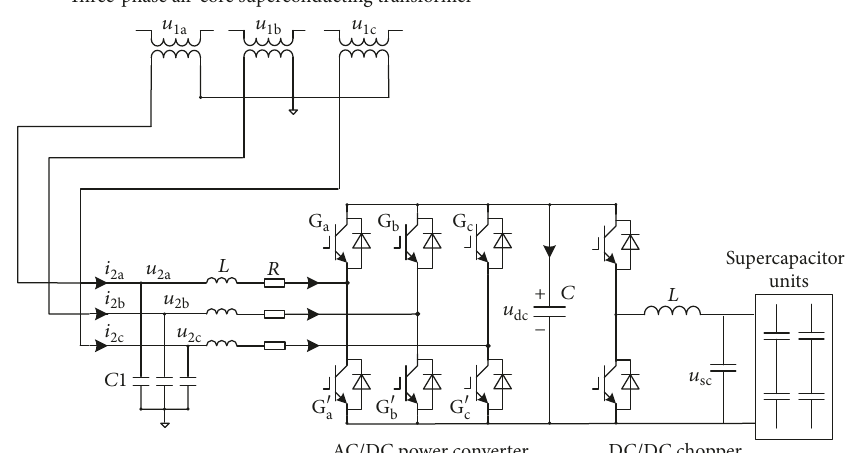
Figure 2: Electrical structure of the active SFCL prototype used in a real three-phase power system.